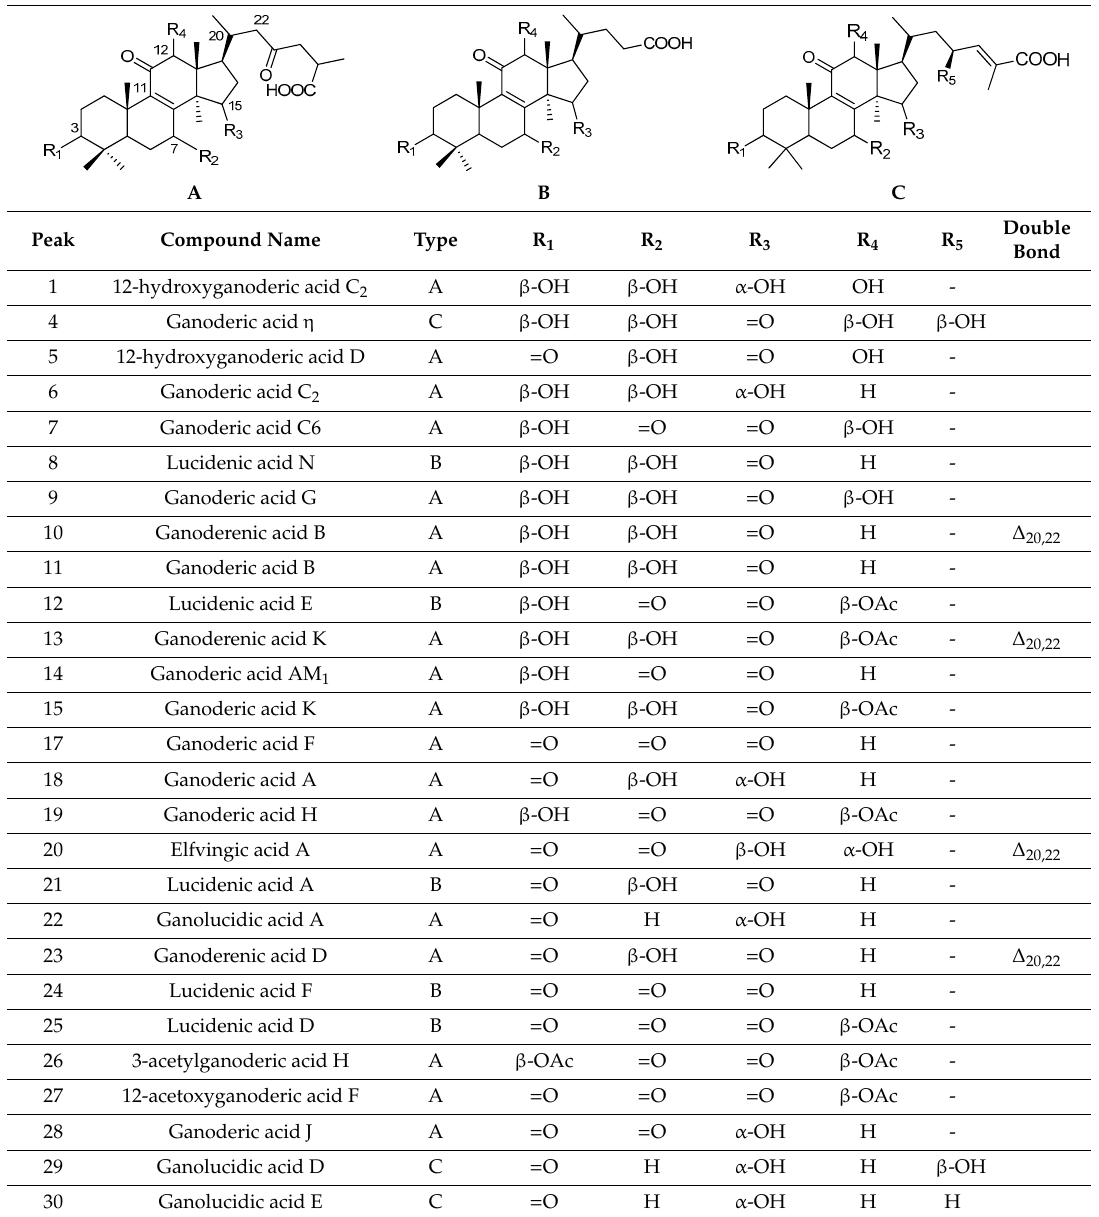
Table 2. Identification of triterpenes in the G. lucidum ethanol extract.